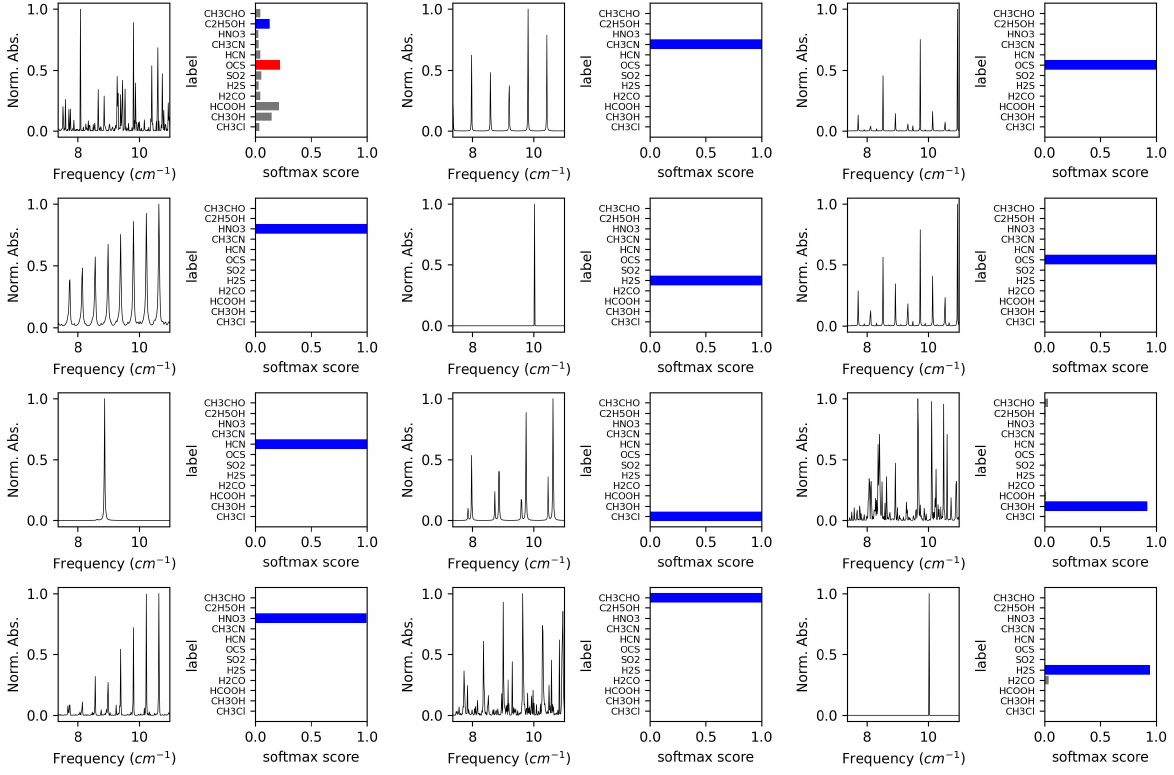
Figure 11. Sampled validation spectra and their corresponding VOC-Net softmax